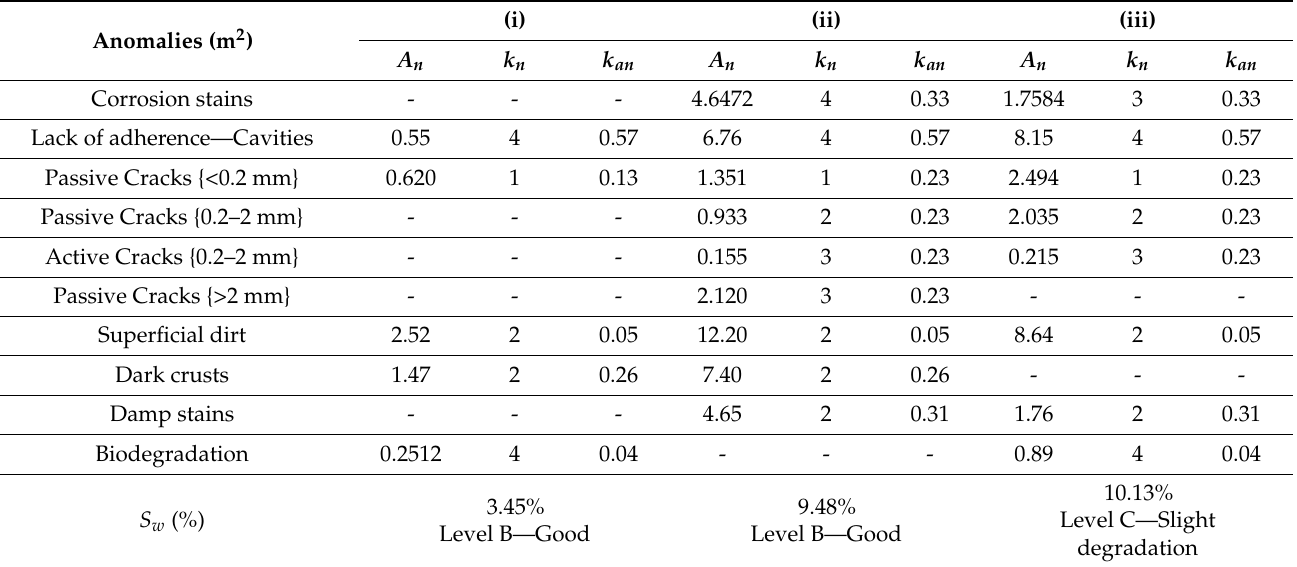
Table 8. Classification and quantification of